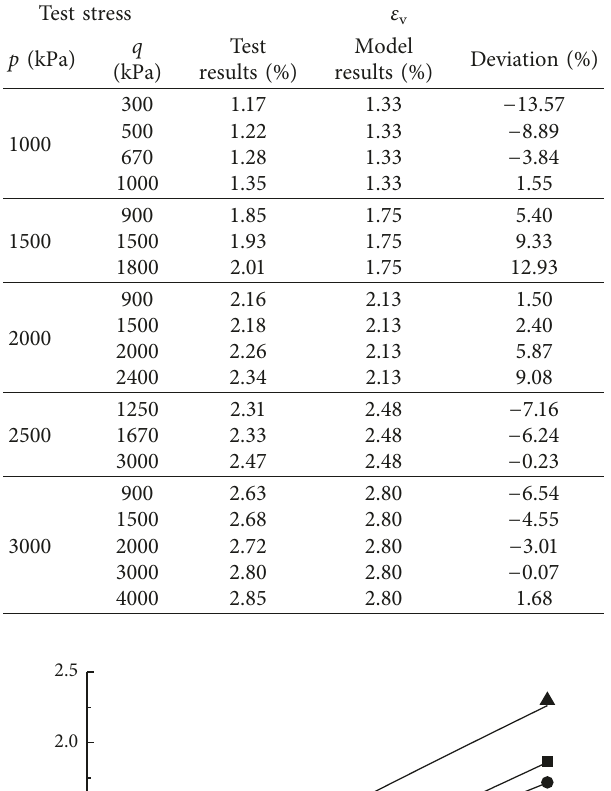
Table 8: Test stress conditions and results (compared with test results and model results for ε v ).